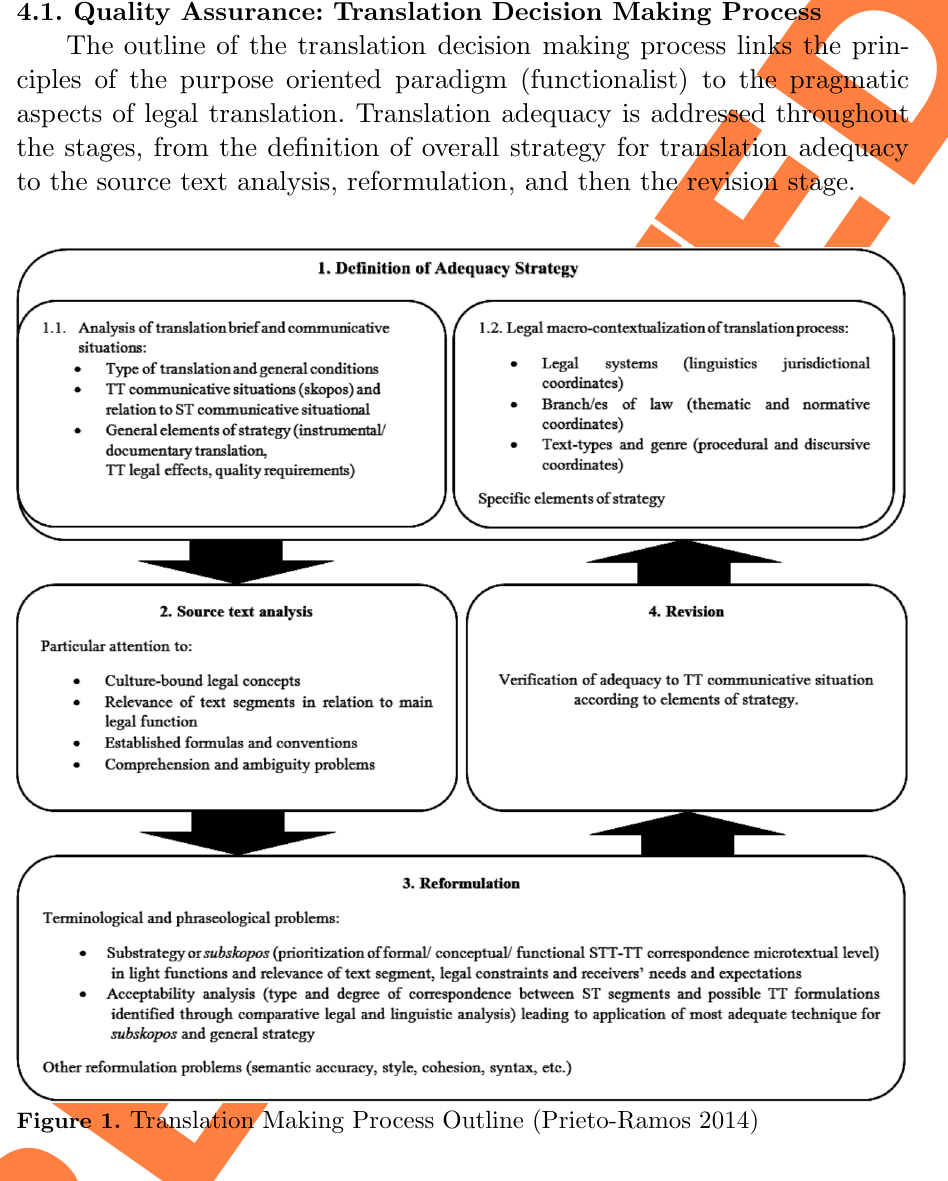
Figure 1. Translation Making Process Outline (Prieto-Ramos